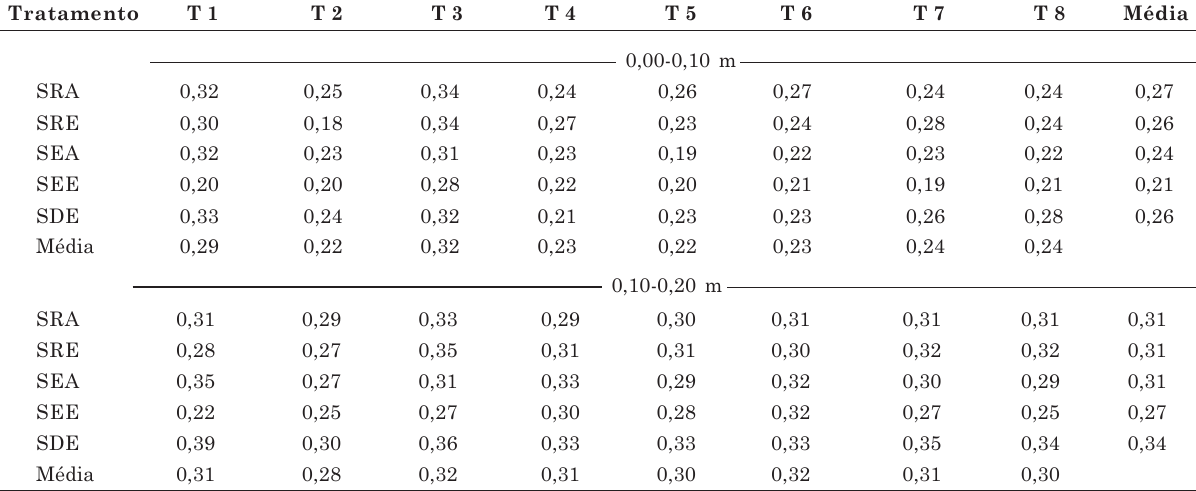
SRA: solo coberto por resíduo de azevém; SRE: solo coberto por resíduo de ervilhaca; SEA: solo escarificado com raiz de azevém; SEE: solo escarificado com raiz de ervilhaca; e SDE: solo descoberto